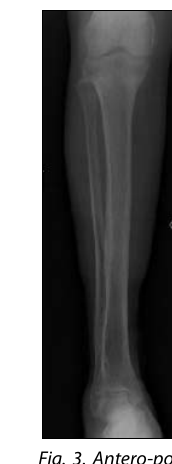
Fig. 3. Antero-posterior view of the right